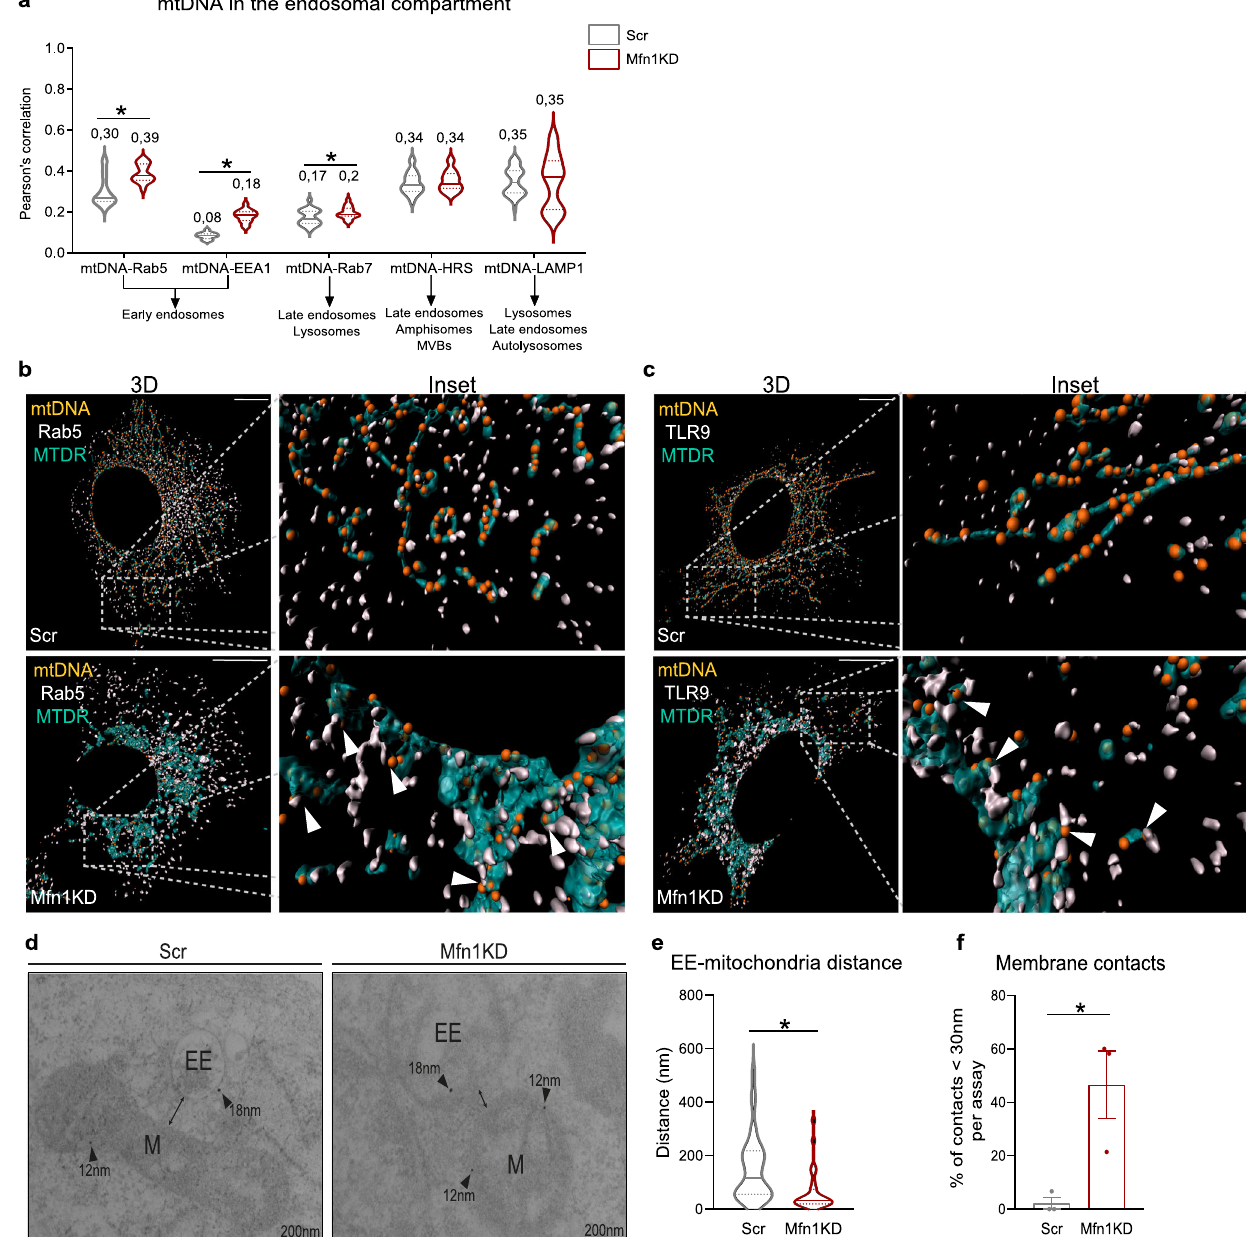
Fig. 4 | Mfn1 de fi ciency causes preferential location of mtDNA and mitochon- dria in early endosomes and promotes close contacts between Rab5 + early endosomes and mitochondria. a Quanti fi cation of Pearson ’ s correlation between mtDNA and endosomal markers ( n =20 images per condition, except for mtDNA- LAMP1, where n =39). Representative 3D reconstructions of immunostainings using dsDNA with nuclear subtraction (mtDNA, orange), mitochondria with Mito- tracker Deep Red (turquoise) and b Rab5 (white) or c TLR9 (white) (Scale bar,10 µ m). d RepresentativeimagesofimmunogoldstainingofRab5(goldparticle 18nm) and SdhA (gold particle 12nm) in Scr- and Mfn1KD myoblasts (Scale bar,